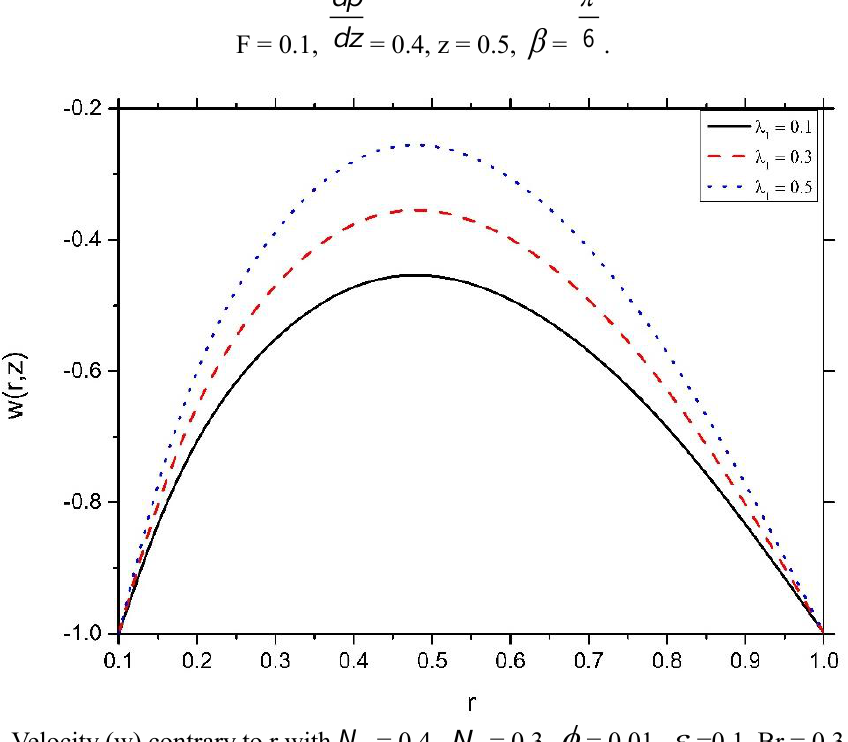
N = 0.4, N = 0.3,  = 0.01,  =0.1, Br = 0.3, F = 0.1, b t dp dz = 0.4, z = 0.5,  =